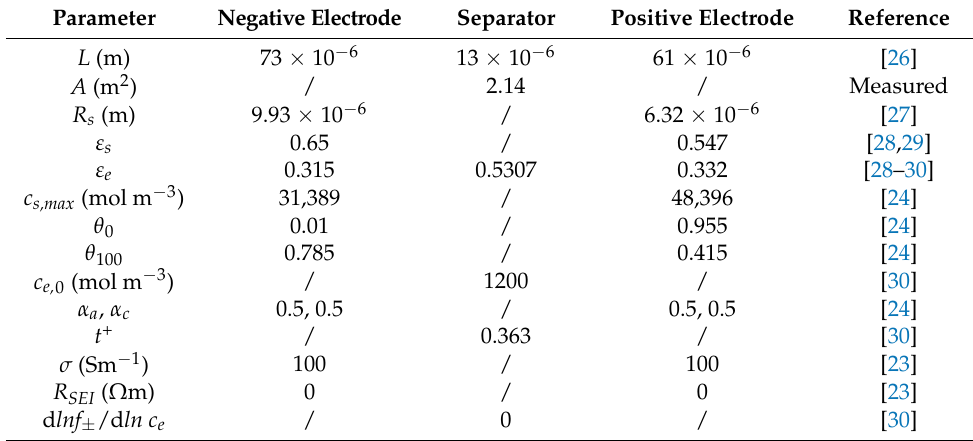
Table 3. Parameter for the PP2D model of the 50Ah battery cell.